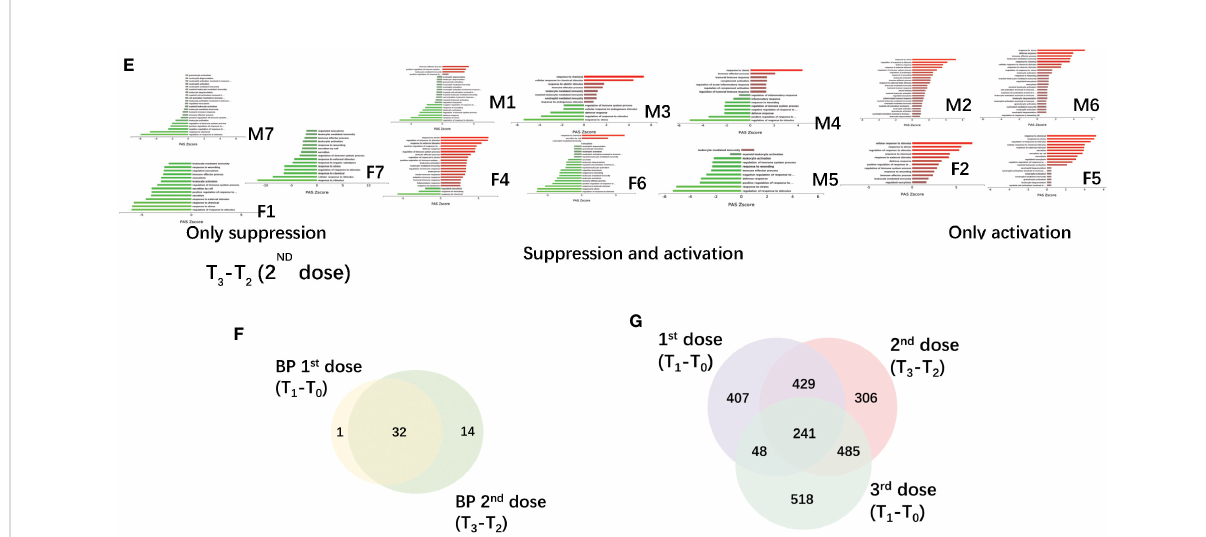
FIGURE 3 Functional analysis of differentially changed proteins in the fi rst and second dose of COVID-19 vaccinees. (A) Demonstration of enriched top 40 immune-related biological processes by differential proteins (fold change > 2 or < 0.5, p-value < 0.05) in the comparison between T 0 (before the fi rst dose of vaccination) and T 1 (24h after the vaccination) of each vaccine, p-value adjusted < e-10. (B) The pathway activation strength value of enriched immune-related biological process (T 1 -T 0 ), which served as the activation pro fi les of the Signaling pathways based on the expression of individual genes. Vaccinees immune responses were suppressed, activated or concurrence. The z-score algorithm was used to predict the activation state (either activated or inhibited) 30 of the biological process. If the z-score ≤ − 2, the process is predicted to be statistically signi fi cantly inhibited. (C) GO and KEGG pathway were enriched for this dataset (T 1 -T 0 ), these enriched processes are statistically signi fi cant with p-value adjusted (p-value: calculated with Fish exact test with Hypergeometric algorithm; p-value adjusted: using ‘ Benjamini- Hochberg ’ method for multiple tests). Network nodes and edges represent proteins and protein – protein associations. Green/red solid lines represent inhibition/activation; gray dotted lines represent GO pathways. Color bar from red to green represents the fold change of protein level from increasing to decreasing. The signi fi cance of the pathways represented by − log (p value) (Fisher ’ s exact test) was shown by color scales with dark blue as most signi fi cant. (D) Demonstration of enriched top 40 immune-related biological processes by differential proteins (fold change > 2 or < 0.5, p-value < 0.05) in the comparison between T 2 (before the second dose of vaccination) and T 3 (24h after the vaccination) of each vaccine, p-value adjusted < e-5. (E) The pathway activation strength value of enriched immune-related biological process (T 3 -T 2 ). More individuals with upregulated immune systems. (F) Venn diagram of signi fi cant top 40 immune-related pathways showing the overlaps between the fi rst and second doses of COVID-19 vaccine (T 1 -T 0 ; T 3 -T 2 ). (G) Venn diagram showing the overlaps of total differentially expressed proteins among before and after 1st dose, 2nd dose, and 3rd dose (T 1 -T 01st ; T 3 -T 2 2nd; T1-T0 3rd